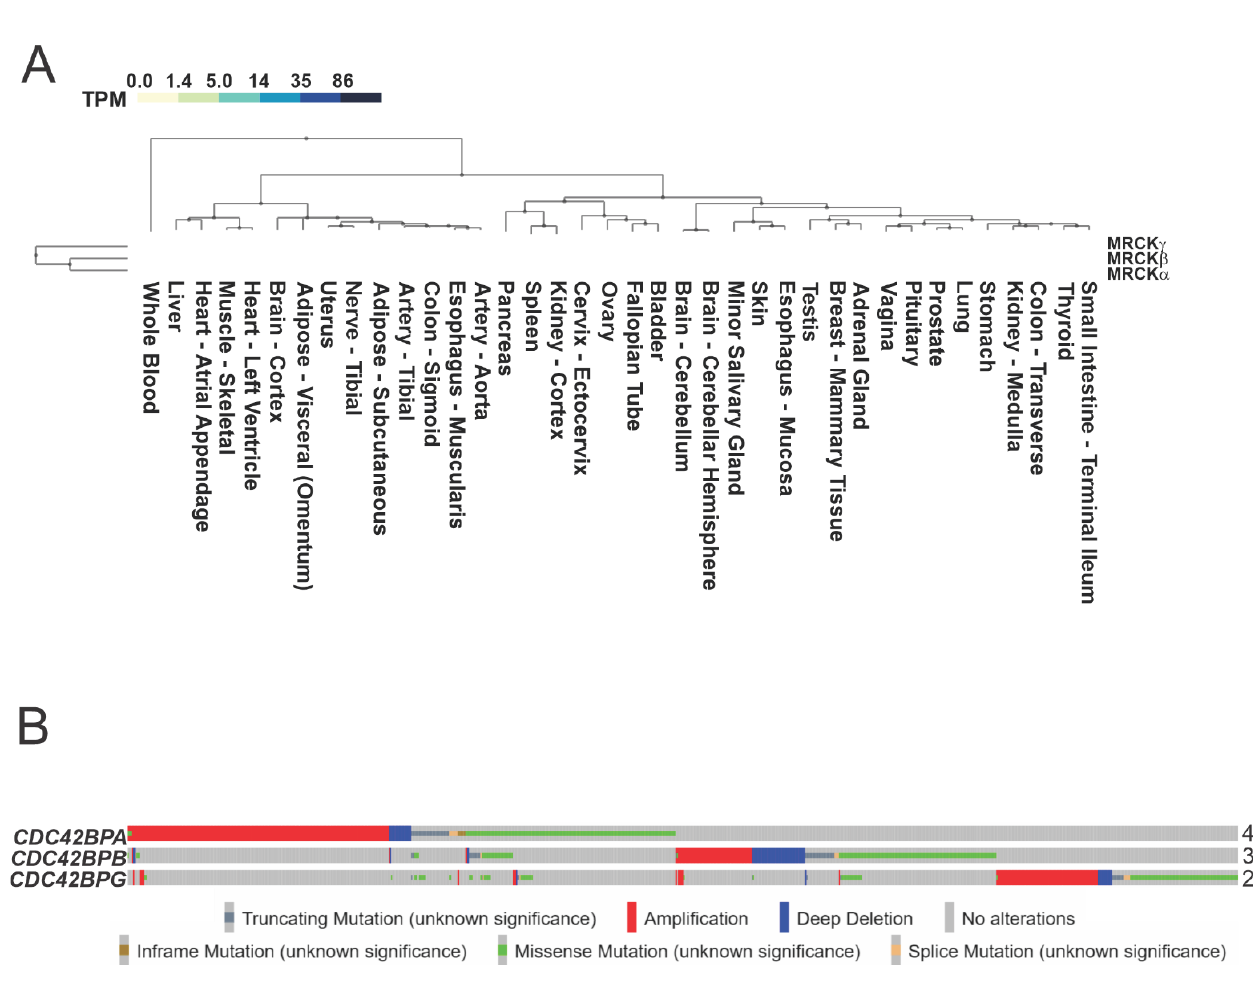
Figure 4. MRCK expression and gene mutations . ( A ). The Genotype – Tissue Expression (GTEx) RNA-Seq database collected from non-diseased tissues across nearly 1000 individuals was queried for the expression levels of MRCK α , MRCK β , and MRCK γ . Values indicate the number of transcripts per million (TPM) for each mRNA. ( B ). The Cancer Genome Atlas program was queried via cBioPortal for genomic alterations to the genes encoding Cdc42BPA, Cdc42BPB, and Cdc42BPG in the TCGA PanCancer Atlas Studies of 32 cancer types.